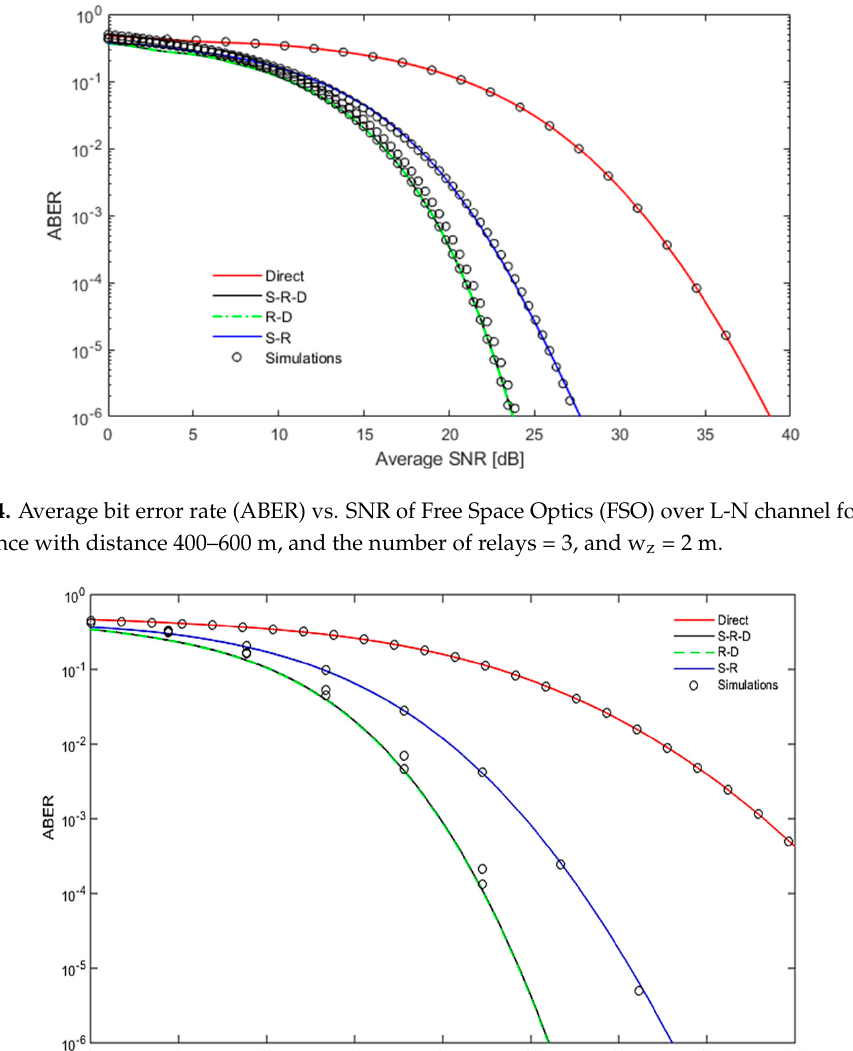
Figure 6. ABER vs. SNR of FSO over L ‐ N channel for moderate turbulence with distance 500 ‐ 500 m, the number of relays = 3, and w z = 2m. The first hop is affected by turbulence more than the second hop as the turbulence increases with the propagation distance assuming that all other parameters are fixed in the 600 m–400 m scheme, as depicted in Figure 7. The S ‐ R scheme, which activates a relay per time slot according to the first hop channel effects, is the best scheme when compared with the other schemes, as it works to improve the first hop SNR gain, which has the dominant effect on the overall system. The obtained results show that the S ‐ R scheme has higher SNR gain than the S ‐ R ‐ D and R ‐ D schemes by 0.5 dB and 6.9 dB, respectively. This SNR gain is due to the selection of the best relay depending on the long distance, S ‐ R, which has the dominant effect.